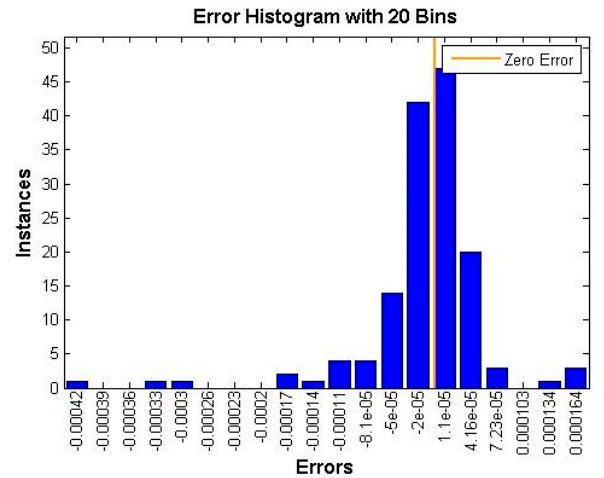
Figure 11. The error histogram measure of the suitability of the TDNN for data. For presentation purposes, GIS was used to illustrate the existing and predicted maps. Each radius was drawn with an angle above the layer of 2015, as shown in Figure 12. As it is noticed, the results indicated that urban expansion was more prevalent in the eastern, northern, and southern areas and less in the west due to the presence of some valleys in this